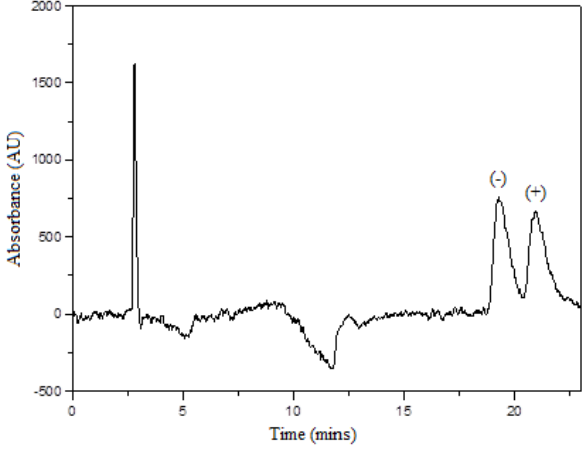
Figure 1: Final chiral method parameters for the separation of Alprenolol racemic mixture using photometric detection. Elution of (-)-Alprenolol and (+)-Alprenolol were seen at ~19 and 21 minutes respectively.